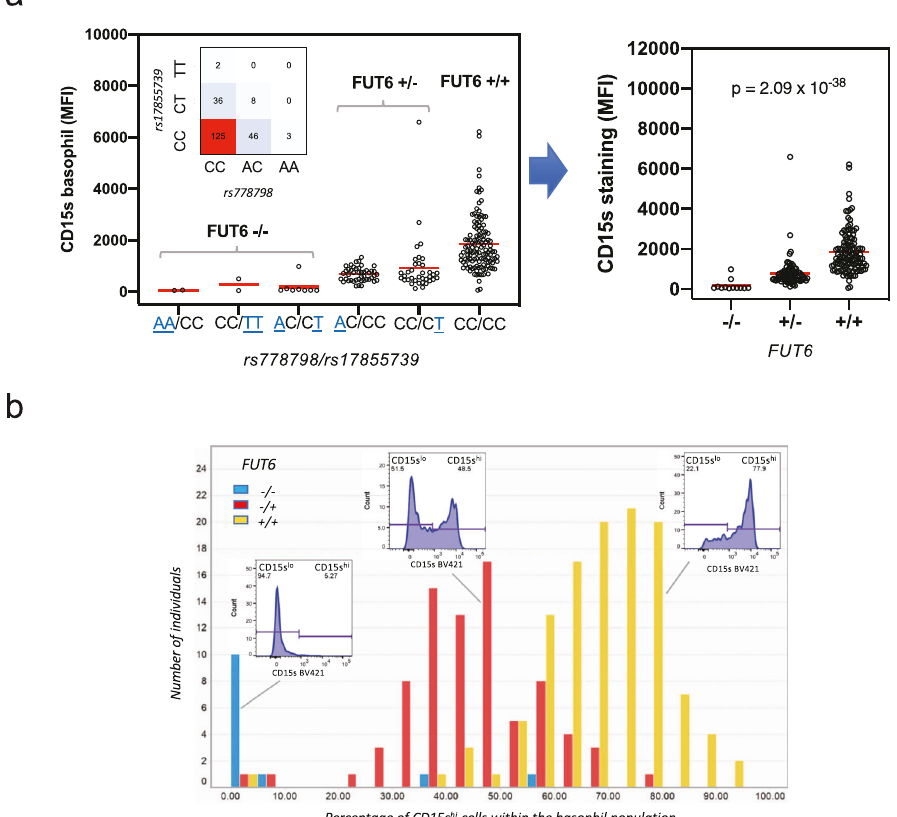
Fig. 5 Association of FUT6 null alleles with the bimodal sLe x expression in basophils. a rs778798/rs17855739-de fi ned FUT6 states. The expression states of FUT6 can be imputed from genotypes of rs778798 and rs17855739. The left panel displays the mean fl uorescence values (MFI) of the CD15s staining of basophils in reference to the rs778798/rs17855739 genotype combination (null alleles are underlined; the inset shows the number of individuals with all genotype combinations detected in the SSIC cohort). The right panel shows the MFI of the CD15s staining vs. the imputed FUT6 status ( + / + , + / − , − / − ). Signi fi cance was determined by Kruskal – Wallis tests. b Impact of FUT6 status on the sLe x expression on basophils. The type of CD15s basophil expression by a donor (CD15s low , CD15s bimodal , CD15s high ) can be described by the percentage of CD15s high cells within the basophil population. The histogram shows the distribution of this parameter within the SSIC cohort. The data were grouped based on the imputed F UT6 status (blue: − / − ( n = 12); red: + / − ( n = 81); yellow: − / − ( n = 122)). Insets show representative FACS histograms of the CD15s basophil staining for each FUT6 status. Bars are binned over a range of